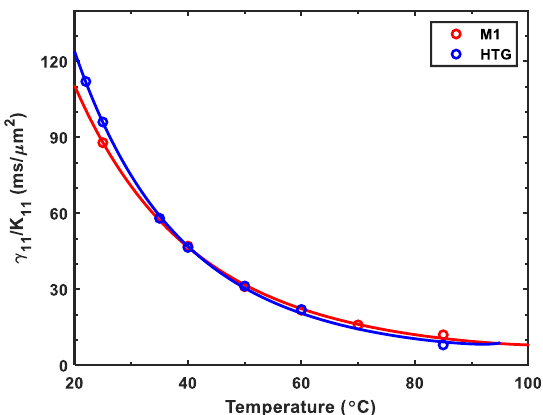
Figure 2. Temperature-dependent visco-elastic constant of M1 and HTG. Dots are measured data and solid lines are fitting curves with Equation (3). The fitting parameters are listed in Table 2.